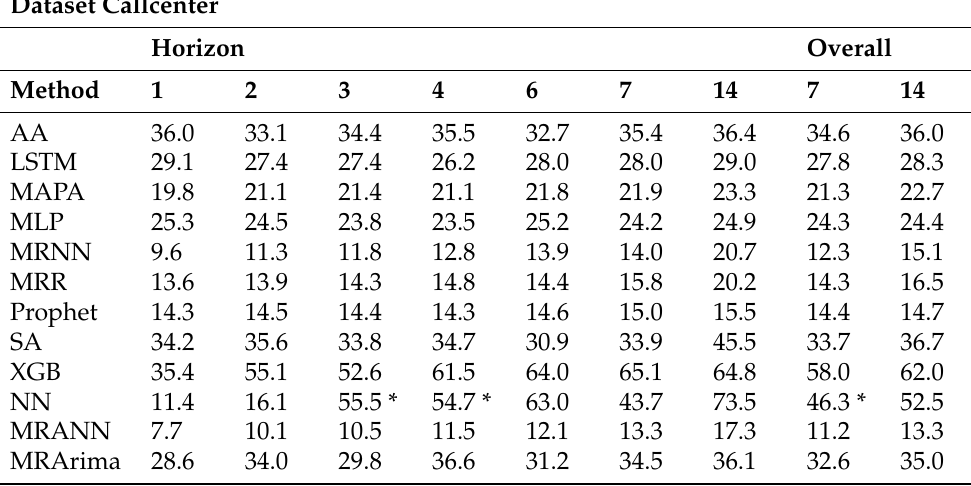
Table A3. Median SMAPE of multi-step forecasts from Prophet, MAPA, the two multiresolution fore- casting methods MRR using regression and MRNN using a neural network, seasonal adapted ARIMA (SA), automatized ARIMA (AA), multilayer perceptron (MLP), long short-term memory (LSTM) and gradient boosting machine (XGB) for different horizons and for the median over horizons from 1 to 7 and 1 to 14. The forecasting techniques denoted with a start (*) did yield a non-significant result for unimodal distributions Hartigans’ dip test with Bonferroni correction meaning that otherwise the distribution is assumed to be